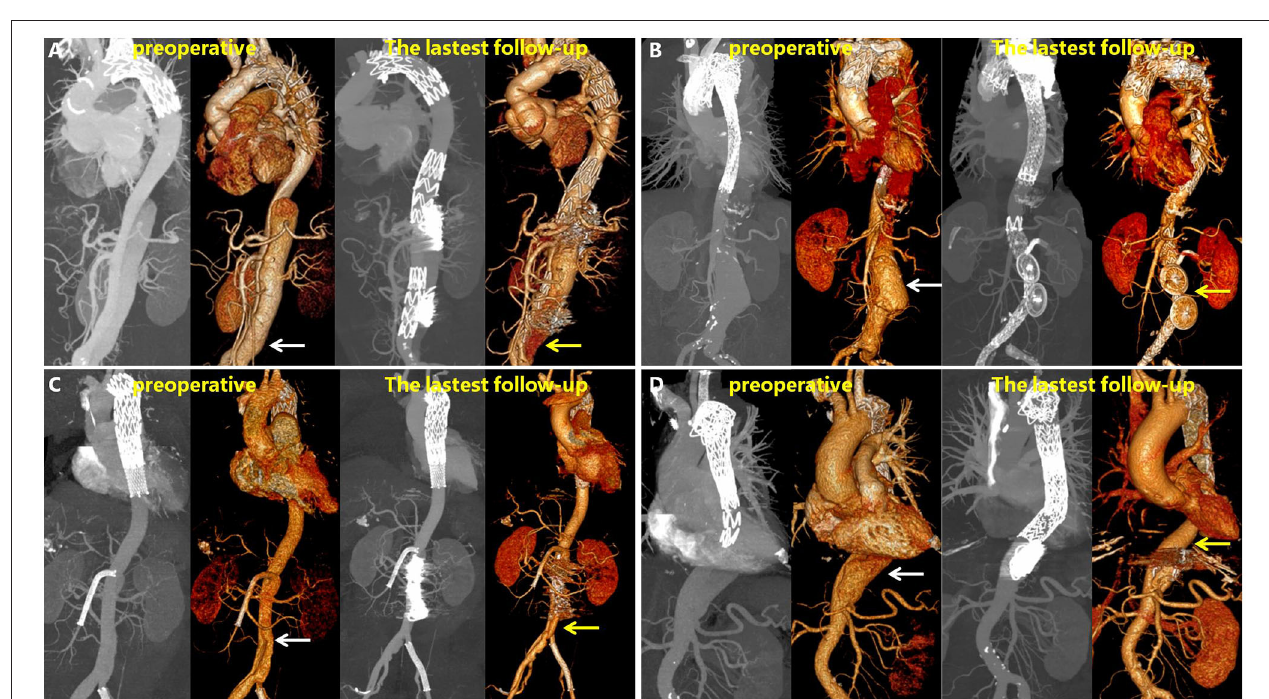
FIGURE 6 | Maximum intensity projection (MIP) and 3D reconstructions of CTA in patients before and after RBS. White arrow points toward dilatation of the FL, and yellow arrow toward thrombosis formation in the FL or shrinking of the FL. (A) Patient’s left renal artery was involved, and a slight endoleak was observed at 31 months. (B) Patient’s left renal artery was involved, the FL disappeared at 43 months on 3D reconstruction images. (C) Patient’s superior mesenteric artery was involved, the FL shrinked at 28 months. (D) Patient’s celiac trunk was involved, the FL shrinked at 25 months.